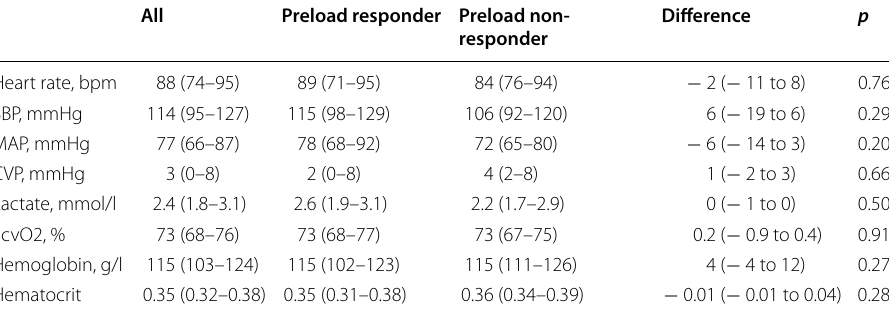
Table 4 Parameters were measured in within 5 min of start of plasma volume measurement